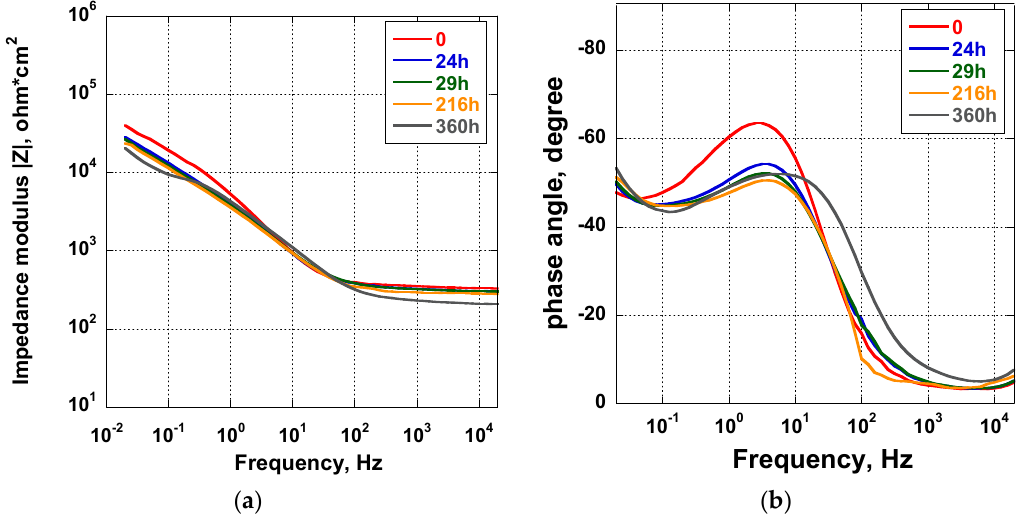
Figure 5. Impedance ( a ) and phase angle ( b ) plots of the Ti_NT org samples immersed in Hanks’ solution for 15 days.